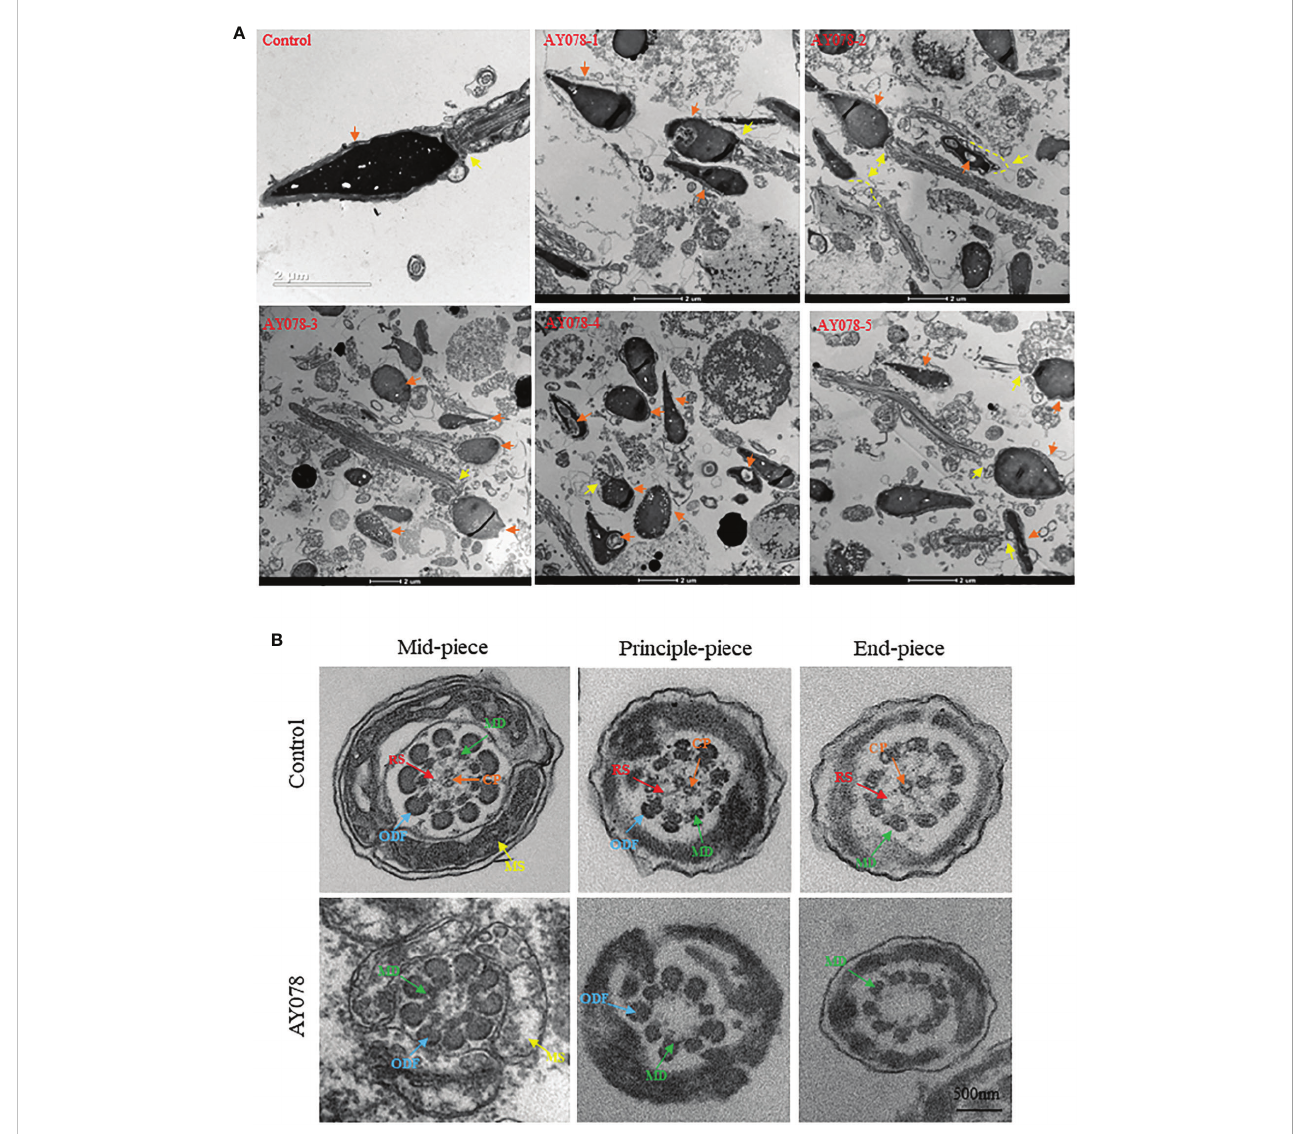
FIGURE 3 Ultrastructural de fi ciency in sperm in HYDIN -de fi cient AY078 comparing with normal control. (A) Magni fi cation of longitudinal section of sperm showed that the anterior two thirds of nucleus was covered by acrosome, which was packaged with OAM and IAM (orange arrow), and fi rm linkage between head and tail in normal-shaped sperm (yellow arrow). While, it was showed that various malformations in AY078: uneven nuclear concentration, damaged and exposed acrosomal contents accompanied the outer acrosomal membrane stripped from the nucleus (orange arrow), abnormal or desultory connection between head and fl agella (yellow arrow). Scale bar: 2 m m. (B) TEM analysis of cross-section ultrastructure within fl agella of AY078 and normal sperm. Typical axoneme and peri-axoneme: ODF, MS in mid-piece or FS in principle-piece surrounded the “ 9+2 ” structure, that nine MDs and one pair CP, were showed in cross-section of mid-piece, principle-piece and end-piece of sperm fl agella from control man. The projection of RS also was captured lightly through TEM in three cross-section of control sperm. It was found that the dramatically reduction of CP and RS complex and destroy on mitochondrial sheath in AY078 fl agella. CP, central pair; MD, microtubules doublet; RS, radical spoke; ODF, outer dense fi ber; MS, mitochondrial sheath; FS, fi brous sheath. Scale bar: 500